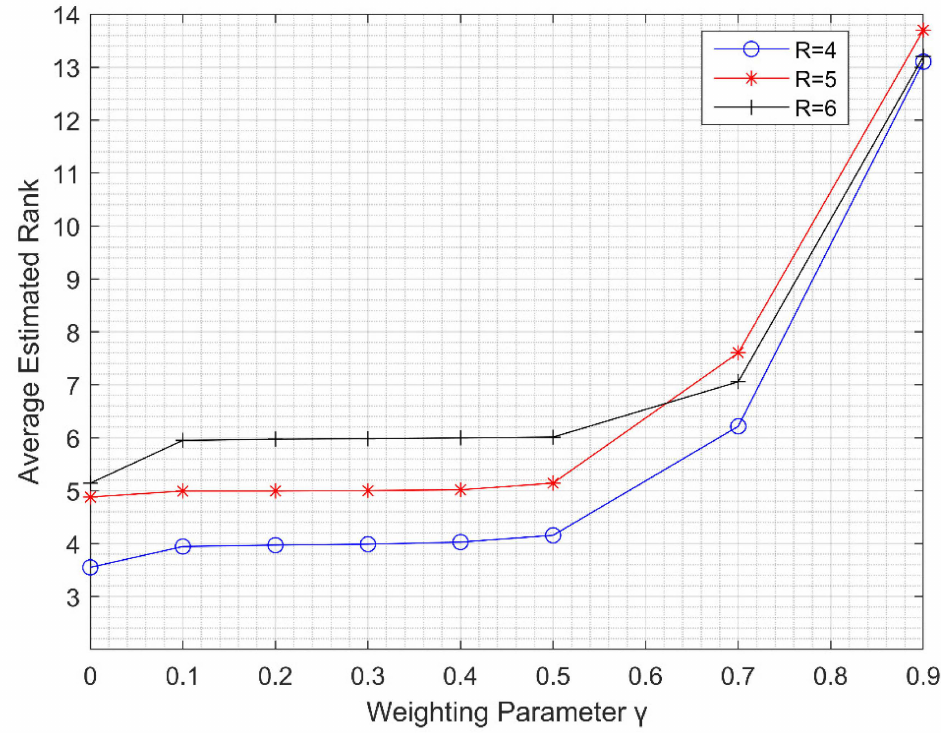
Figure 9. Rank estimation performance of the proposed method as a function of weighting